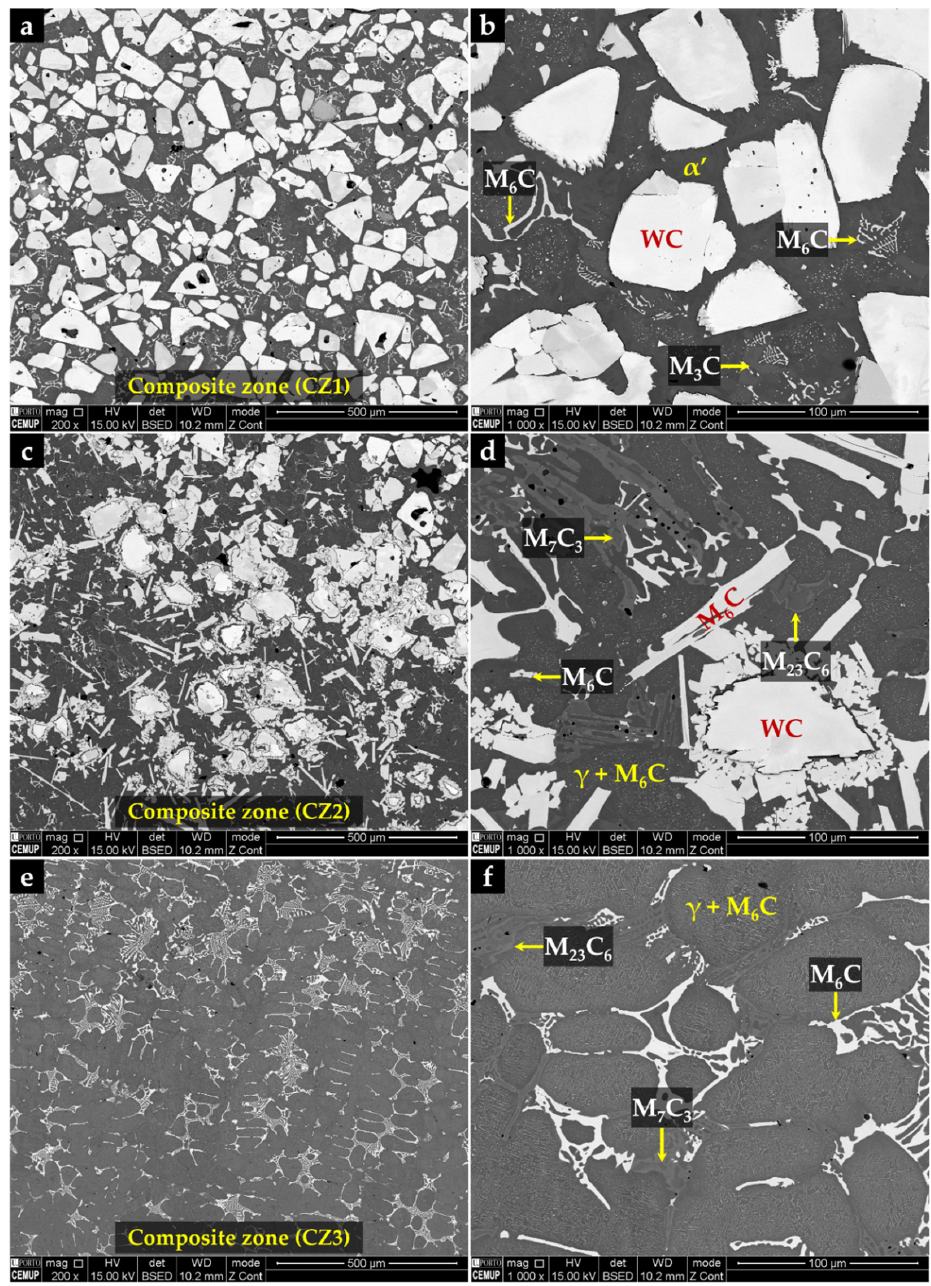
Figure 4. SEM-BSE images of the microstructure of the composite zone: ( a ) zone nearest surface—CZ1, ( b ) higher magnification of ( a ) showing large polygonal-shaped WC particles and precipitation of (Fe,W,Cr) 6 C and (Fe,W,Cr) 3 C; ( c ) intermediate zone—CZ2, ( d ) higher magnification of ( b ) showing (Fe,W,Cr) 6 C precipitated around a WC particle and carbides with a core of (Fe,Cr,W) 7 C 3 and a shell of (Fe,Cr,W) 23 C 6 ; ( e ) inner zone near to the base metal—CZ3, and ( f ) higher magnification of ( e ) showing the interdendritic network of (Fe,Cr,W) 7 C 3 , (Fe,Cr,W) 23 C 6 , and (Fe,W,Cr) 6 C and fine precipitates of (Fe,W,Cr) 6 C in the γ matrix.